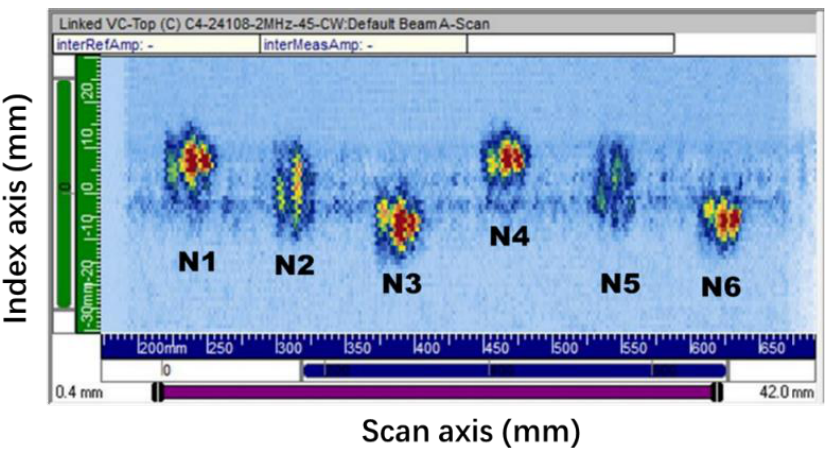
Figure 7. The C-scan image generated based on the amplitude of original A-scan signals obtained by detection.